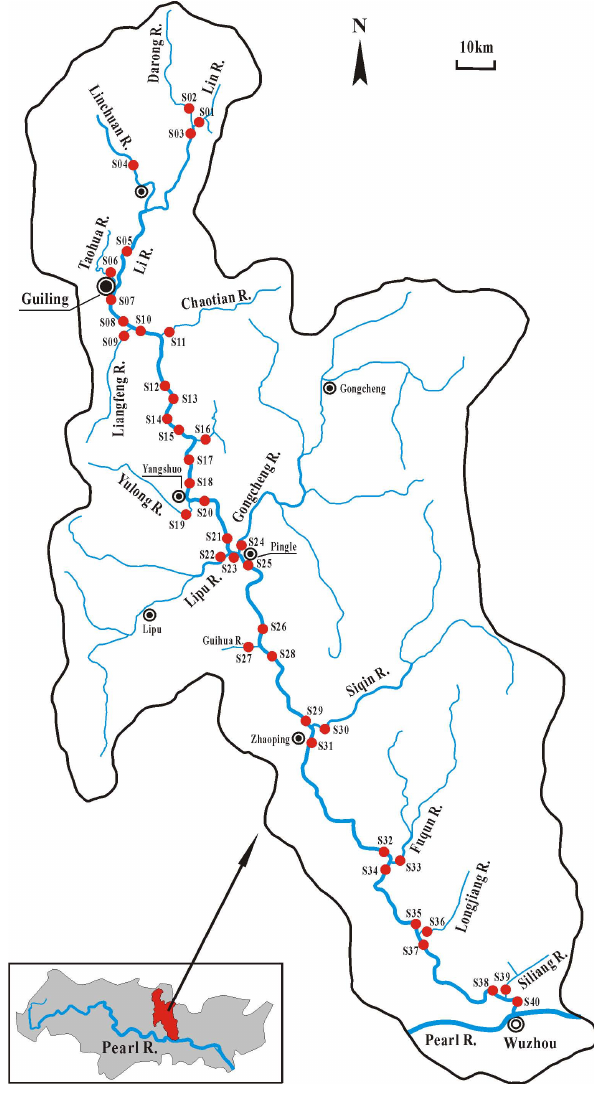
Fig. 3. Map of the Guijiang River catchment and sampling locations (filled red